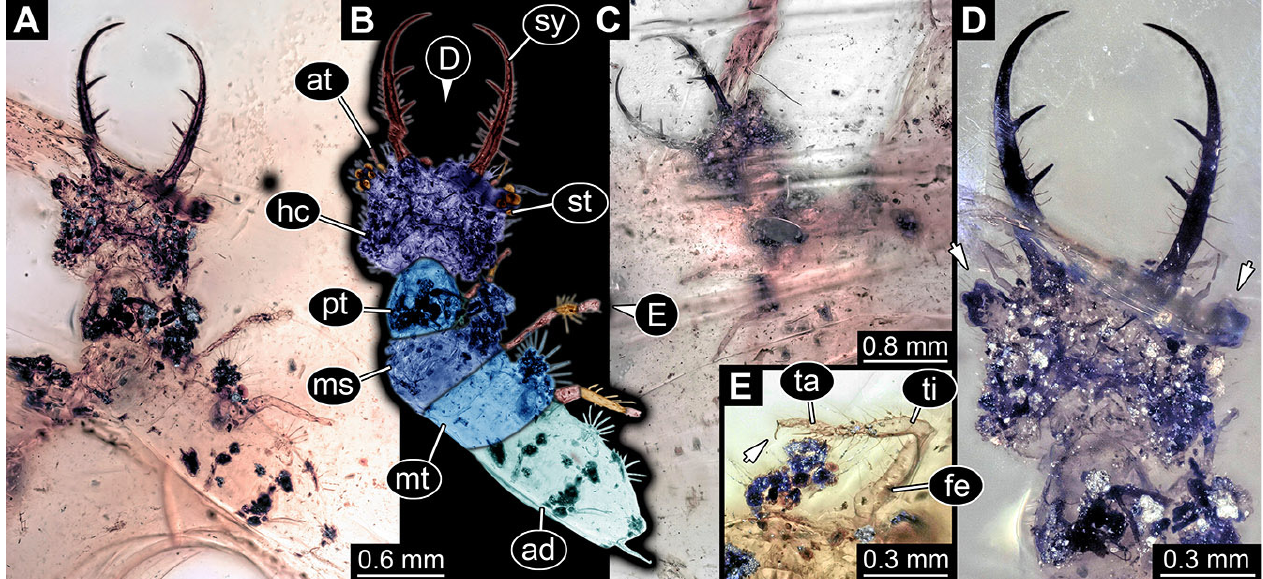
Figure 26. Fossil owllion larva, specimen 3239 (PED 0378), Cretaceous Kachin amber, Myanmar. ( A ) Overview, dorsal. ( B ) Color-marked version of ( A ). ( C ) Overview, ventral. ( D ) Close-up on head capsule with fields of stemmata (arrows). ( E ) Close-up on locomotory appendage with claws (arrow). Abbreviations: ad = abdomen; at = antenna; fe = femur; hc = head capsule; ms = mesothorax; mt = metathorax; pt = prothorax; st = stemmata; sy = stylet; ta = tarsus; ti = tibia.